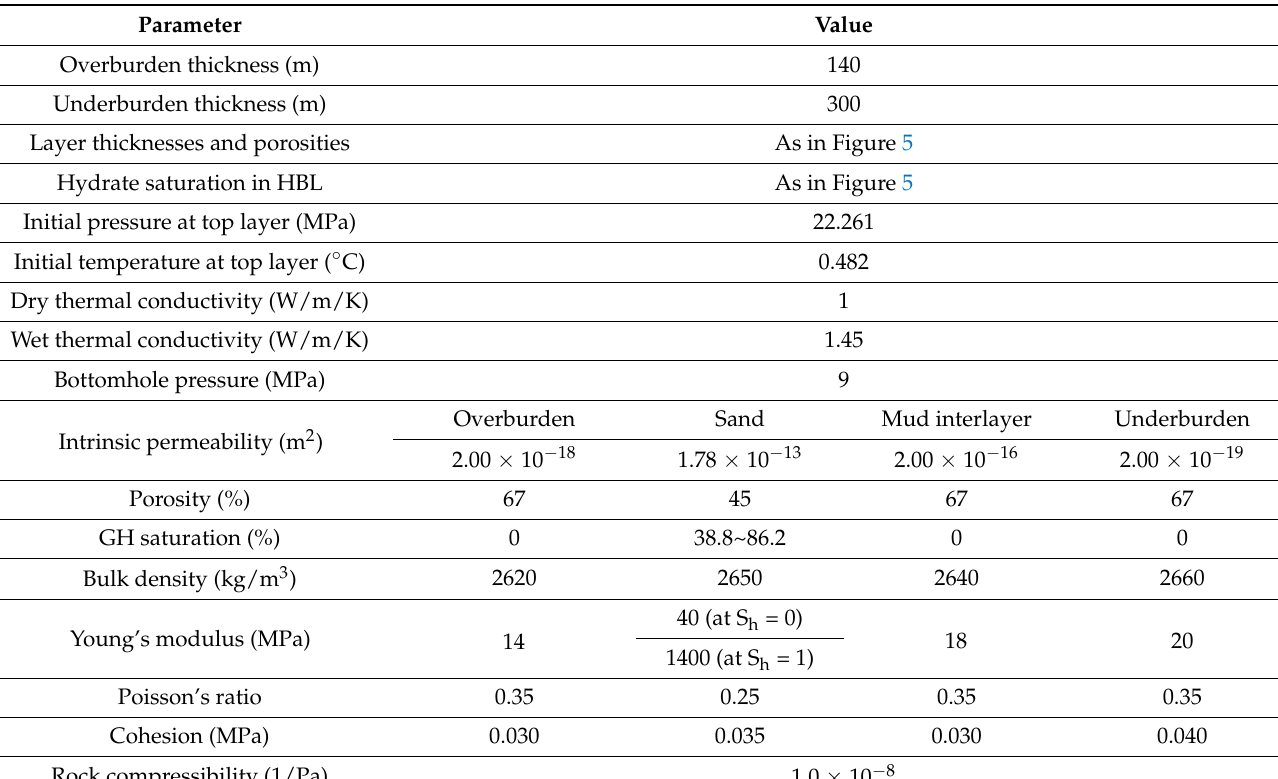
Figure 5. Schematic diagram of UBGH2-6 [33]. Table 1. Initial conditions and properties.